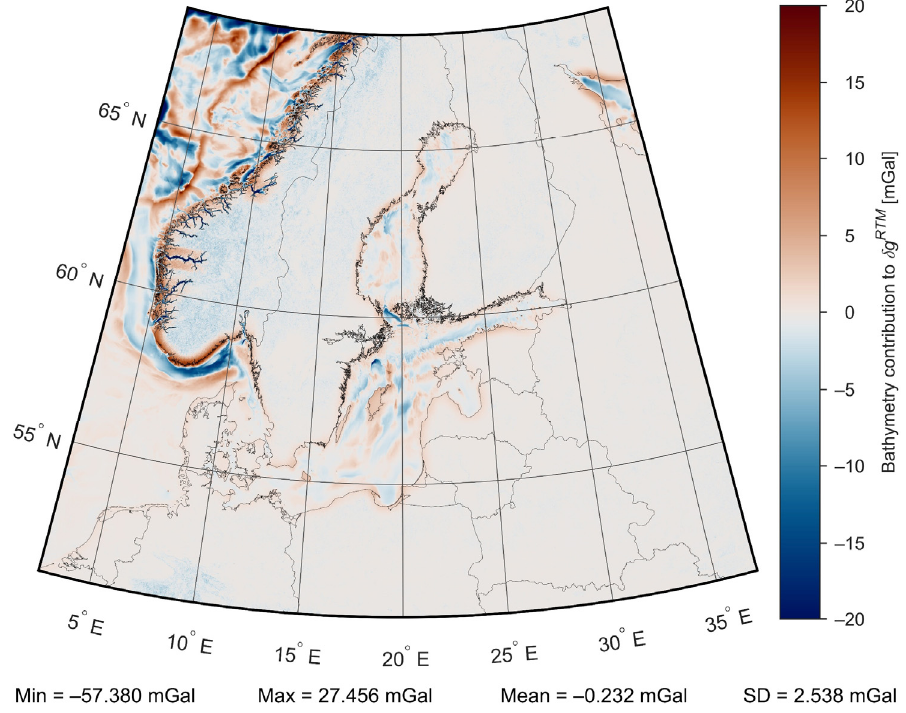
Figure 7. Bathymetry contribution to RTM reduction.